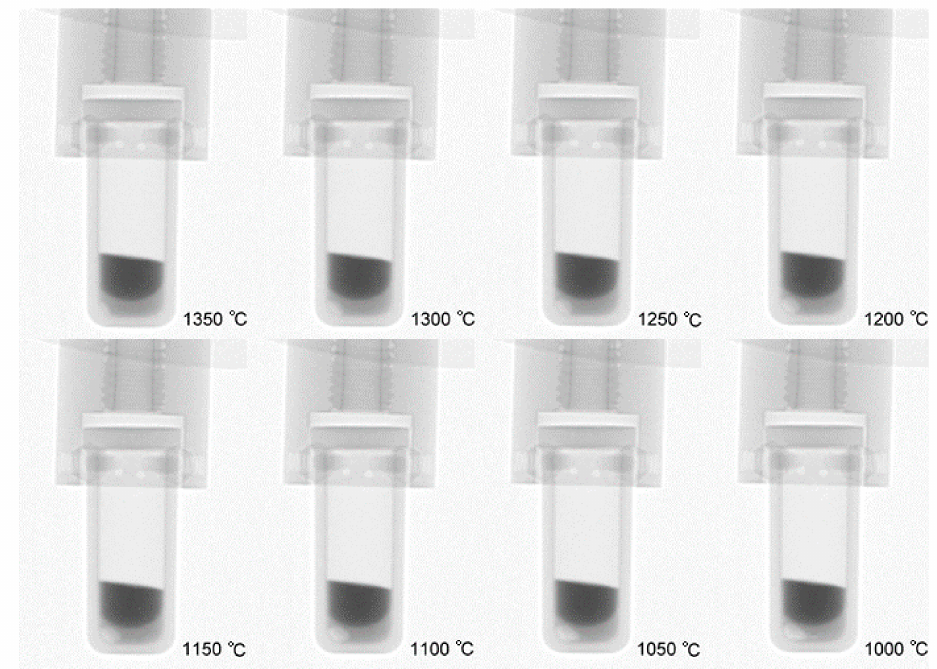
Figure 8. Cooling, macroscopic void formation, and